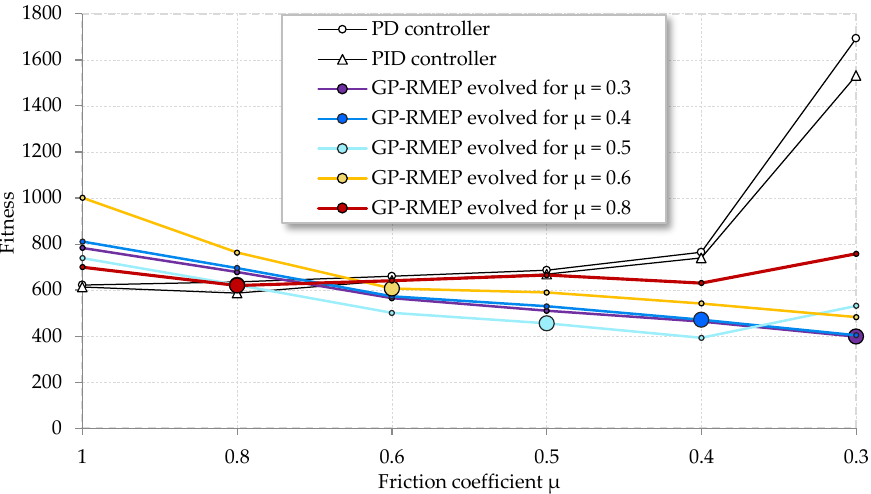
Figure 8. Generality of the best-evolved steering functions manifested by a reasonable change in their respective fitness value when tested on different (unforeseen during the evolution) friction coefficients. The fitness of the steering functions evolved for a particular friction coefficient is indicated by larger circular markers.